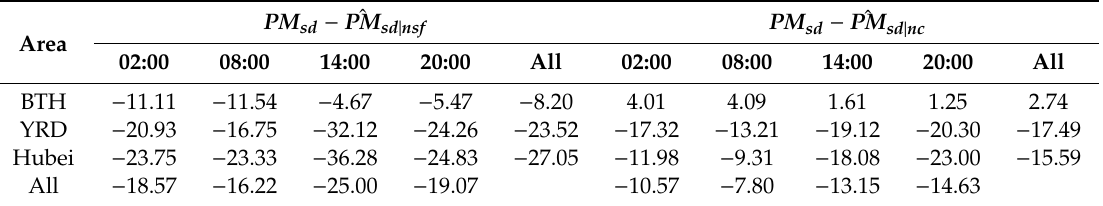
Table 4. (a) For 02:00, 08:00, 14:00, and 20:00, restricting factories and vehicles during SD caused PM